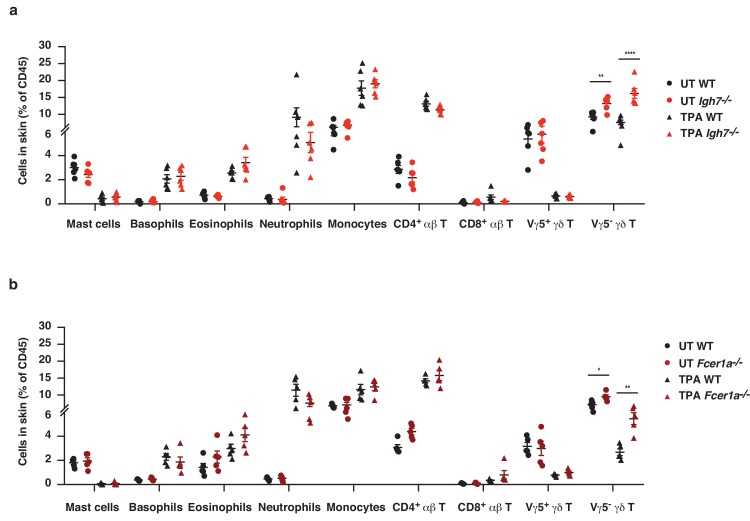
The cellular immune composition of inflamed skin is unaltered in the absence of IgE-mediated signalling.(a, b) Ear skin of WT and (a) Igh7–/– or (b) FceR1a–/– mice was treated topically with TPA, twice a week for two weeks, and the cellular immune composition of the skin was analysed by FACS and compared to that of UT healthy skin. The gating strategy used for all cell populations is detailed in the 'Materials and methods' section. Data are presented as means ± SEM of total CD45+ leukocytes in the skin. The gating strategy for specific cell populations is outlined in methods. Statistical analysis was performed by one-way ANOVA multiple comparison; *p<0.05, **p<0.01 and ****p<0.0001. UT = untreated.